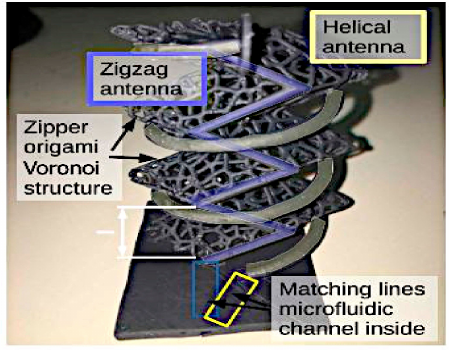
Figure 30. 3D printed antenna tree